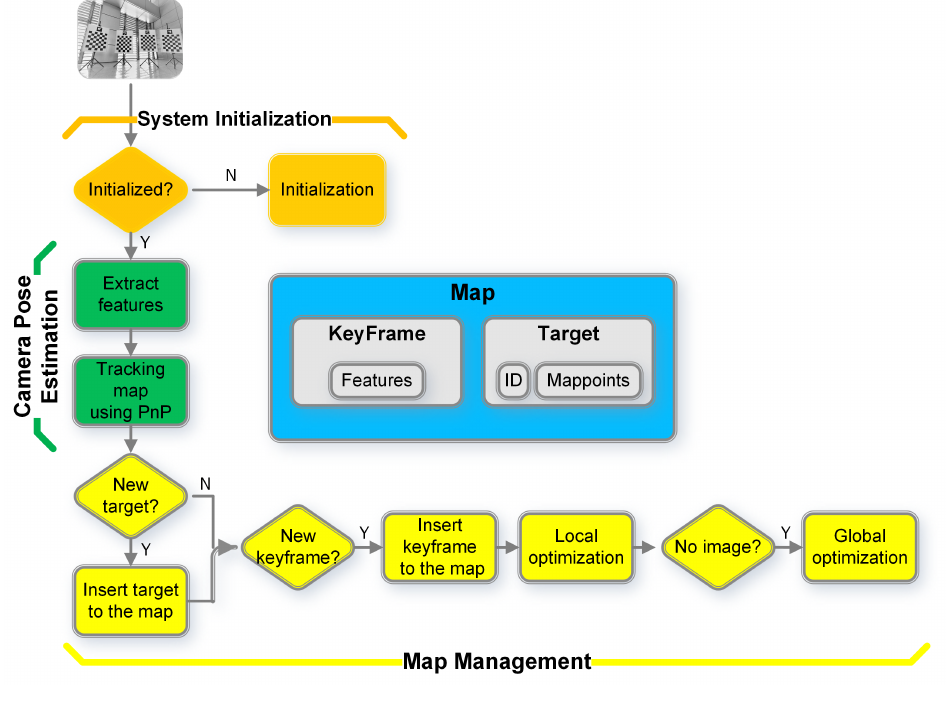
Figure 3. Process of keyframe poses